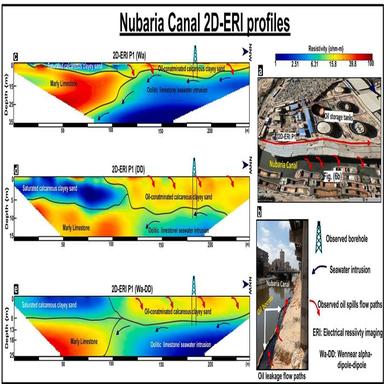
(a) 2D-ERI P1 profile parallel to Nubaria Canal showing oil-contaminated soil and (b) oil leakage flow path towards Nubaria Canal. Profiles at c, d and e represent 2D electrical resistivity models of 2D-ERI P1 obtained from 2D inversion of Wa, DD and combined Wa and DD (Wa-DD) datasets, respectively, and calibrated with borehole information and RS data.